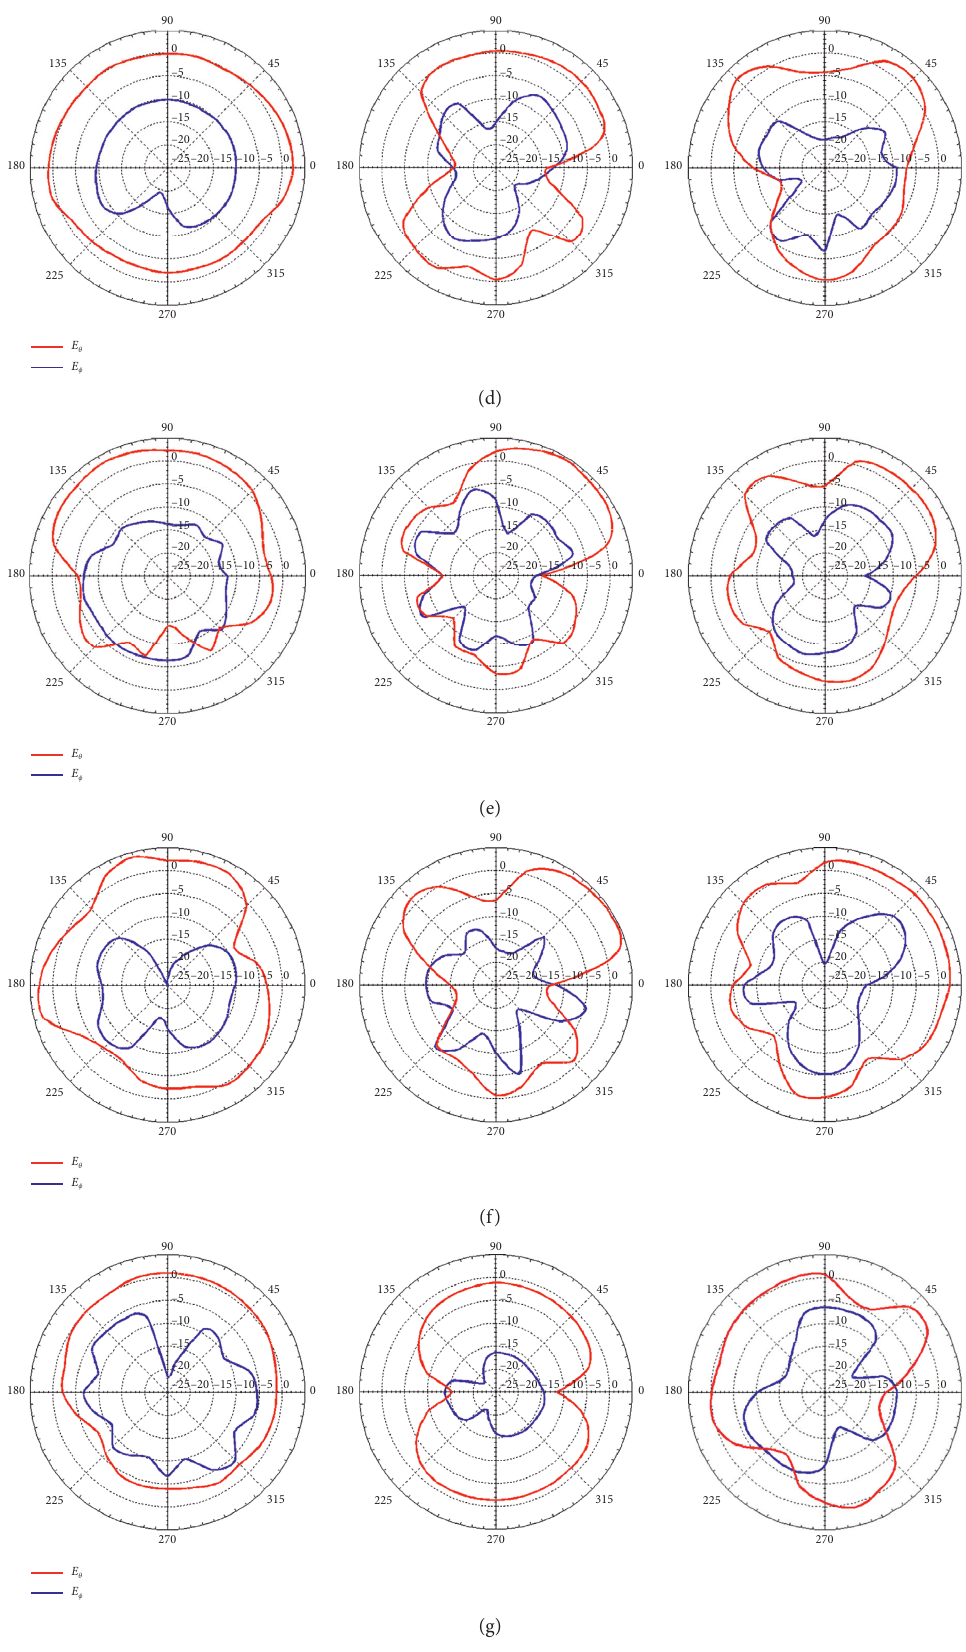
Figure 8: Measured 2D antenna radiation patterns at x - y , x - z , and y - z planes: (a) 760MHz; (b) 850MHz; (c) 2340MHz; (d) 2690MHz; (e) 3400MHz; (f) 4000MHz; (g)